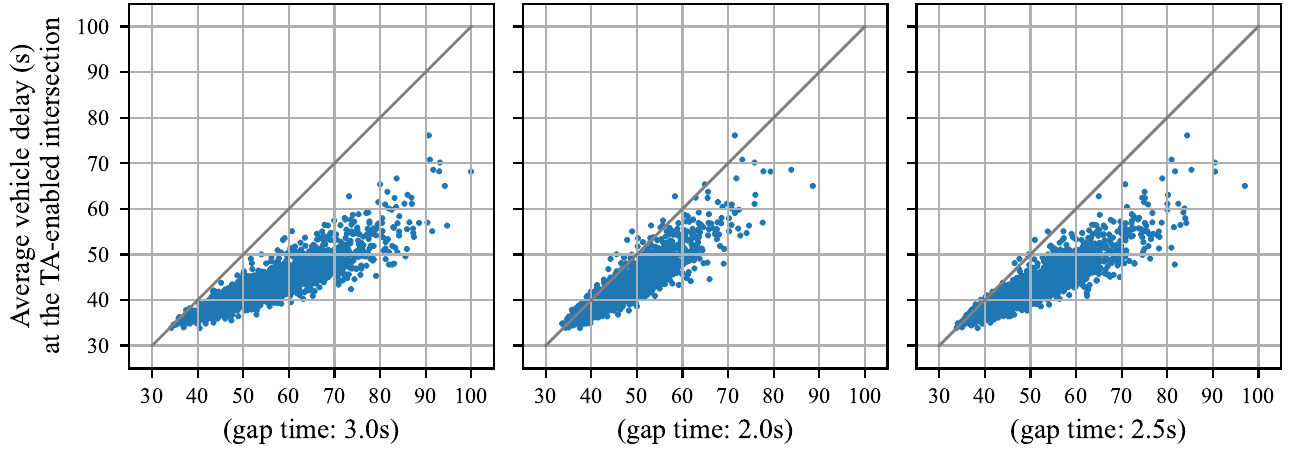
Figure 7. Scatter plot of the average vehicle delay at the TA-enabled and FACT-enabled intersections in each demand scenario with different gap times. Each dot represents a demand scenario, with the x-coordinate and y-coordinate denoting the average vehicle delay at the FACT-enabled and TA-enabled intersections, respectively.